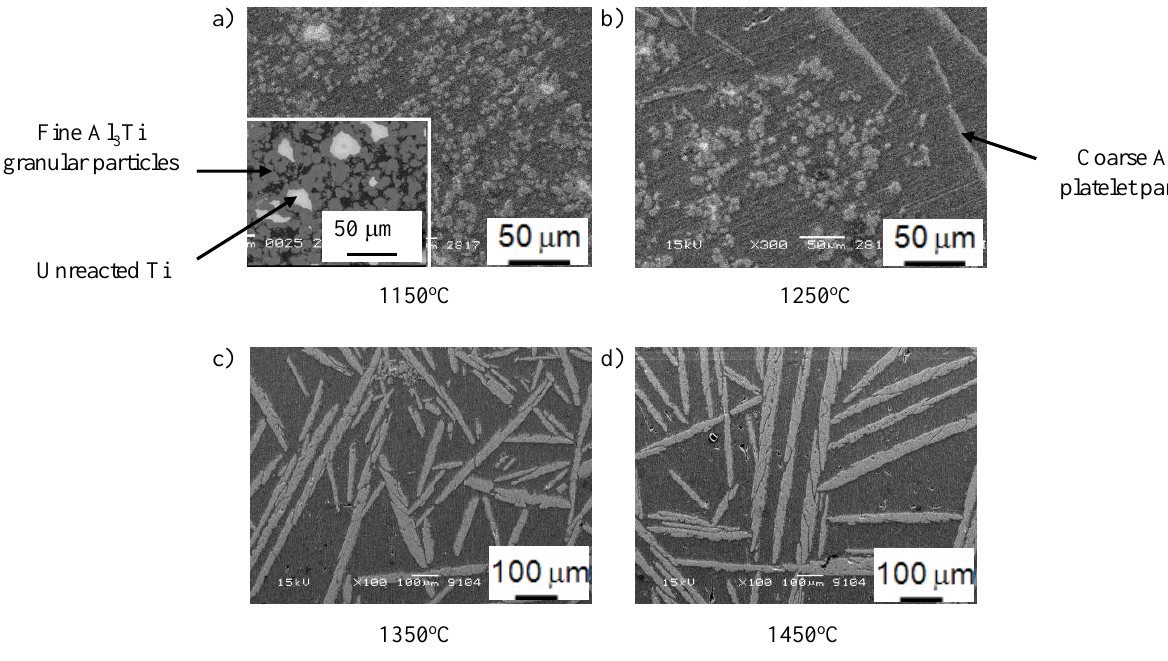
Figure 13. Scanning Electron Microcopy (SEM) micrographs of RCMPM-FGMs processed at different temperatures